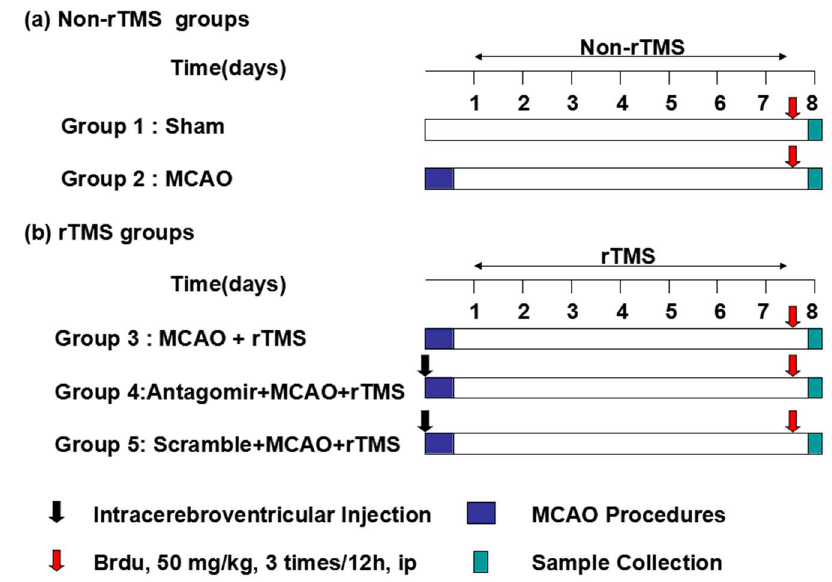
Figure 1. Experimental protocol.